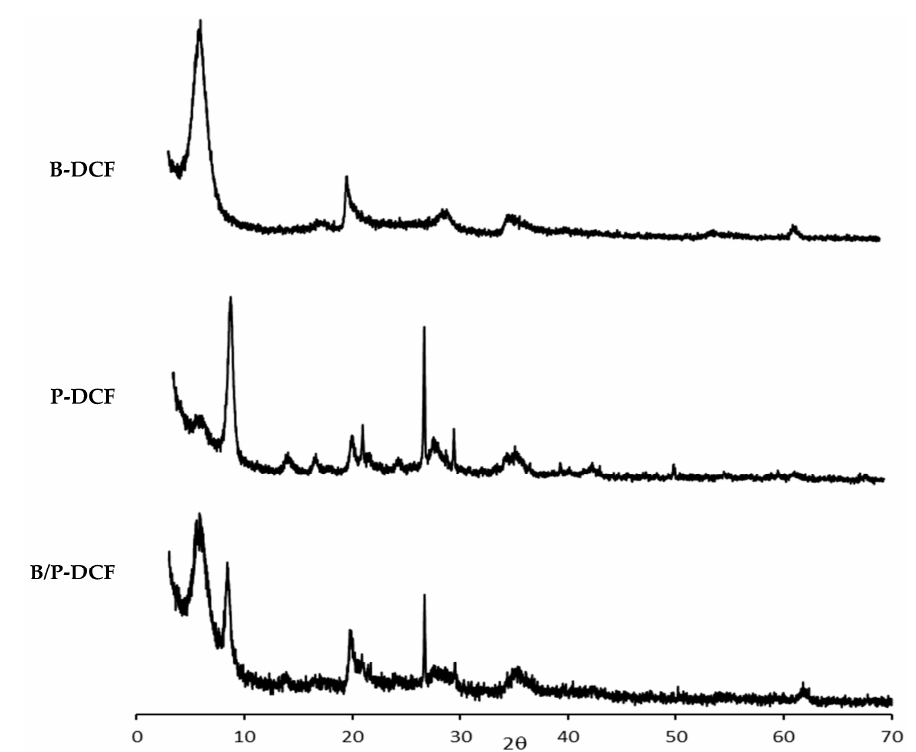
Figure 4. XRD of B-DCF, P-DCF, and B/P-DCF gels.